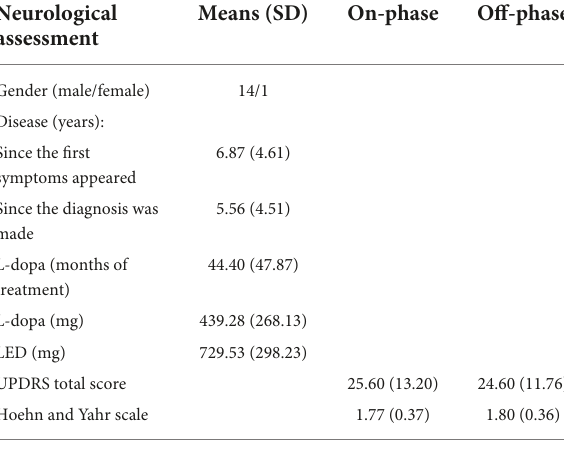
TABLE 1 Mean values (SD) for individuals with PD on demographic and clinical assessment carried out by a neurologist prior to the study. Neurological